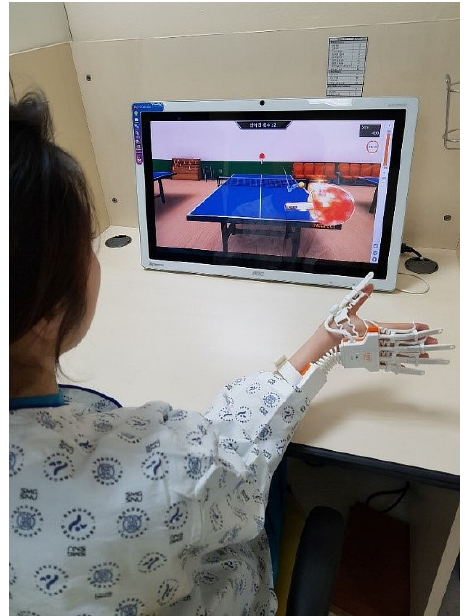
Figure A3. Illustration of the rehabilitation program using a wearable device.